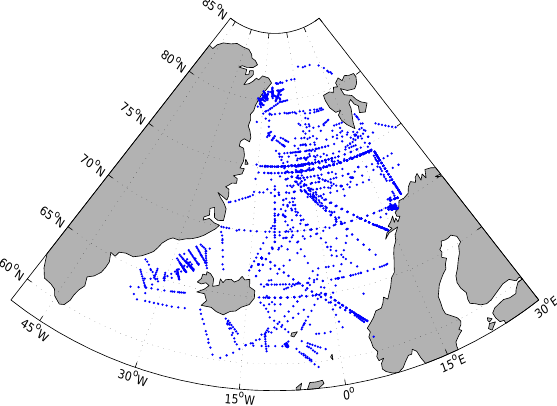
Figure 1. Nordic Seas with nutrient sampling positions. Includes only data retained in CARINA after secondary quality